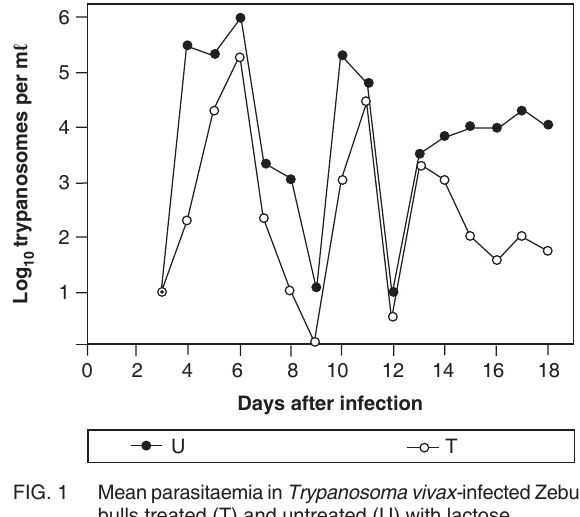
Mean parasitaemia in Trypanosoma vivax- infected Zebu bulls treated (T) and untreated (U) with lactose